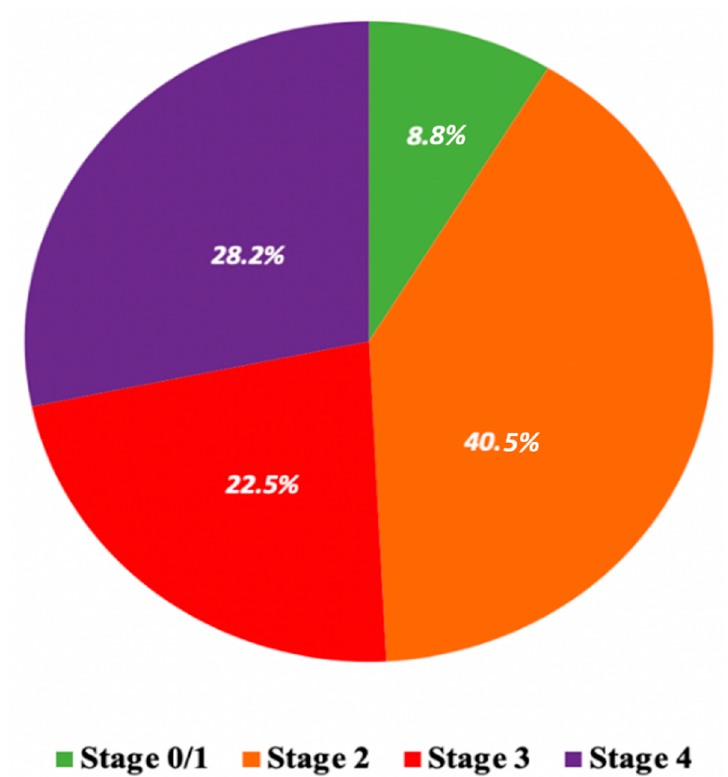
Figure 1. Distribution of stages of cardiac damage in the study population. Table 1. Baseline characteristics of patient population according to the stage of cardiac damage.